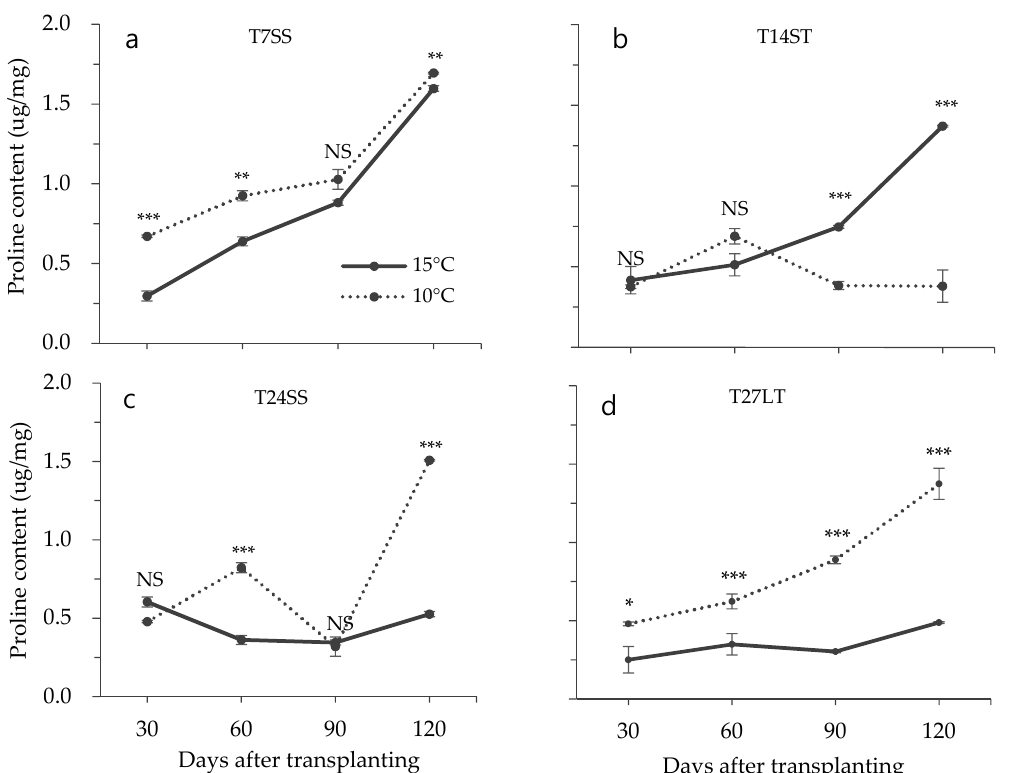
Figure 8. Changes in proline contents in the leaves of cherry-type accessions T7SS ( a ) and T14ST ( b ), and of large-fruit-type accessions T24SS ( c ) and T27LT ( d ) grown in 10 and 15 °C. SS: small sensitive, ST: small tolerant, LS: large sensitive and LT: large tolerant. Values are means ± SD (n = 3). NS, *, ** and *** indicate not significant and significant at the p ≤ 0.05, p ≤ 0.01 and p ≤ 0.001 levels in t -test, respectively.